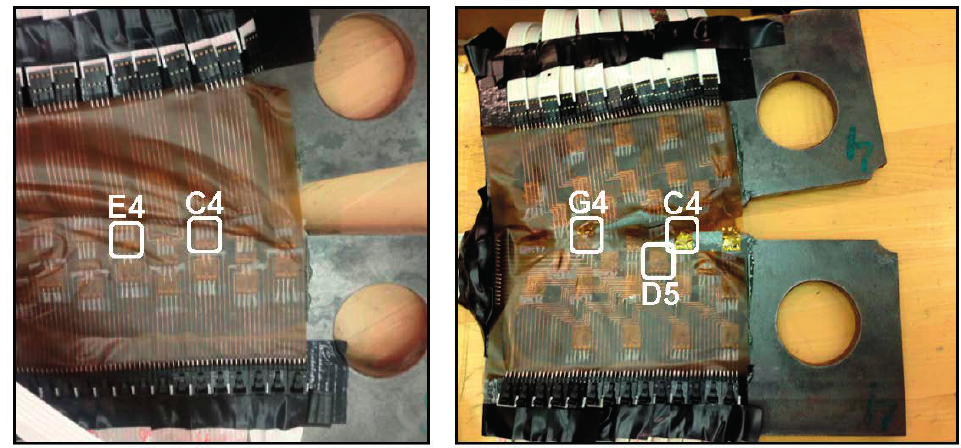
Figure 15. Typical failure modes of the sensing sheet under excessive crack opening; ( Left ): delamination, Plate #3 (Design 2); ( Right ): tearing, Plate #4 (Design